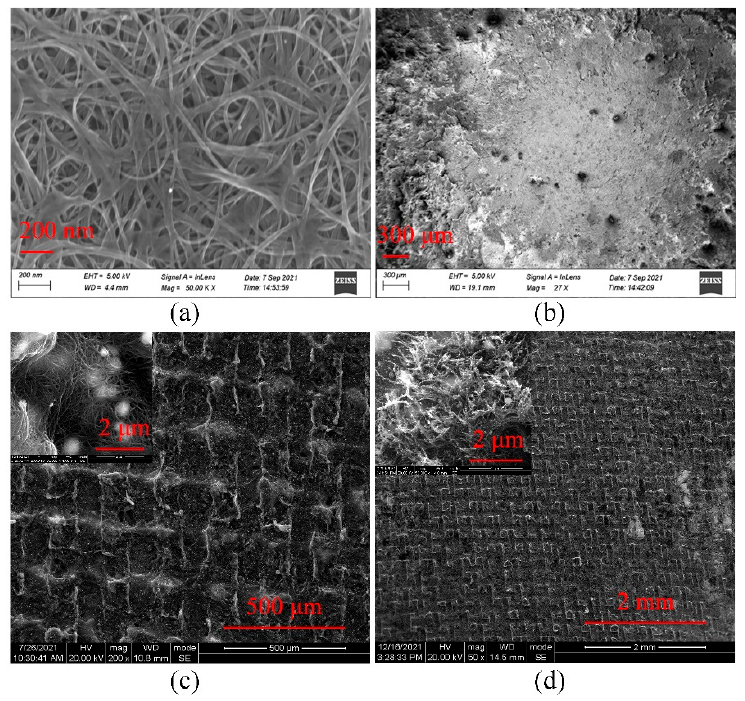
Figure 2. The SEM image of ( a ) the electrophoretic SWCNT cathode before and ( b ) after field emission test, ( c ) the screen printed SWCNT cathode before and ( d ) after field emission test. The insets of ( c , d ) are corresponding high-resolution SEM images before and after the field emission